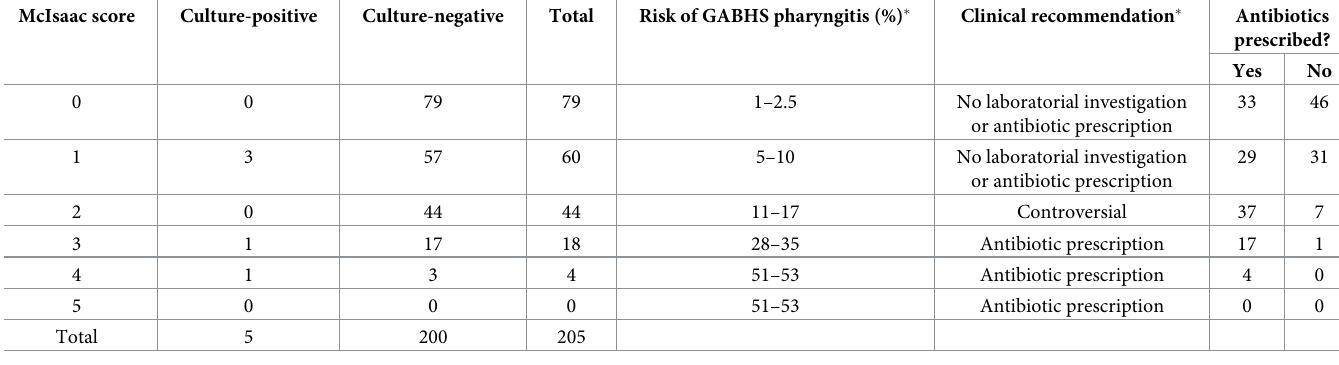
Table 7. Antibiotic prescription appropriateness based on McIsaac score. McIsaac score